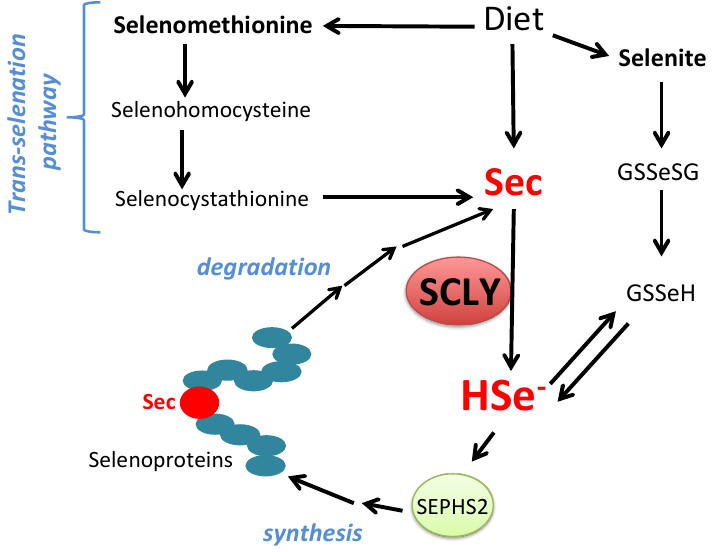
Figure 2. Schematic view of SCLY participation in selenium metabolism. Sec, selenocysteine; HSe - , selenide; GSSeSG, selenodiglutathione; GSSeH, selenoglutathione; SEPHS2, selenophosphate synthethase 2.